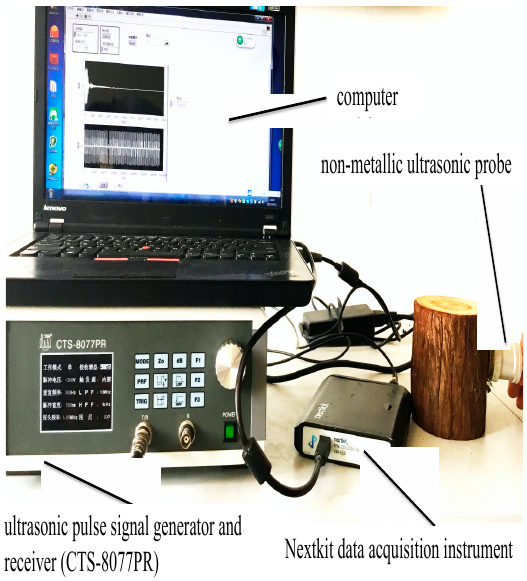
Figure 1. The ultrasonic plant stem detection system.